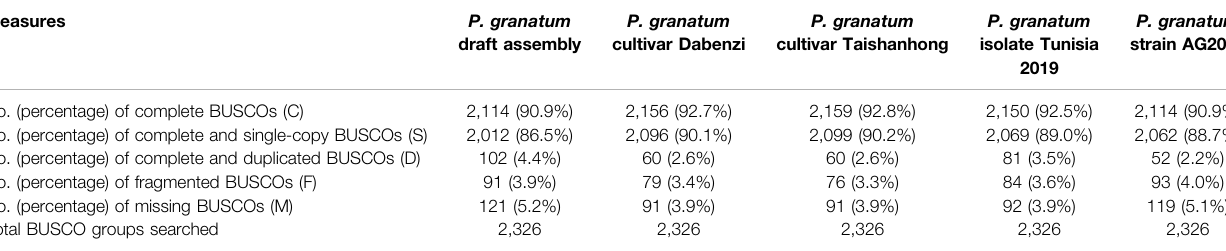
TABLE 2 | Qualitative analysis of draft genome